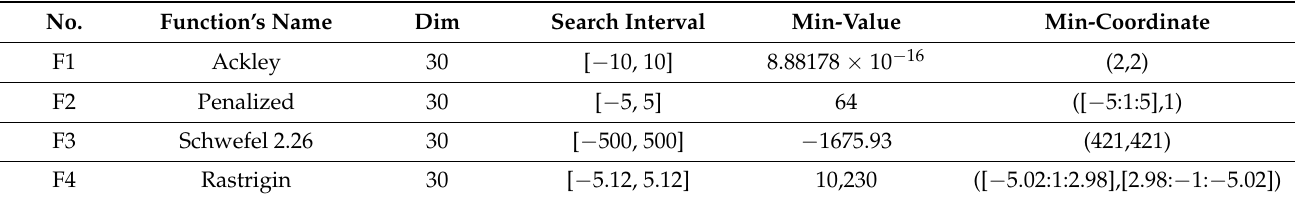
Table 1. Function Maximum Optimization